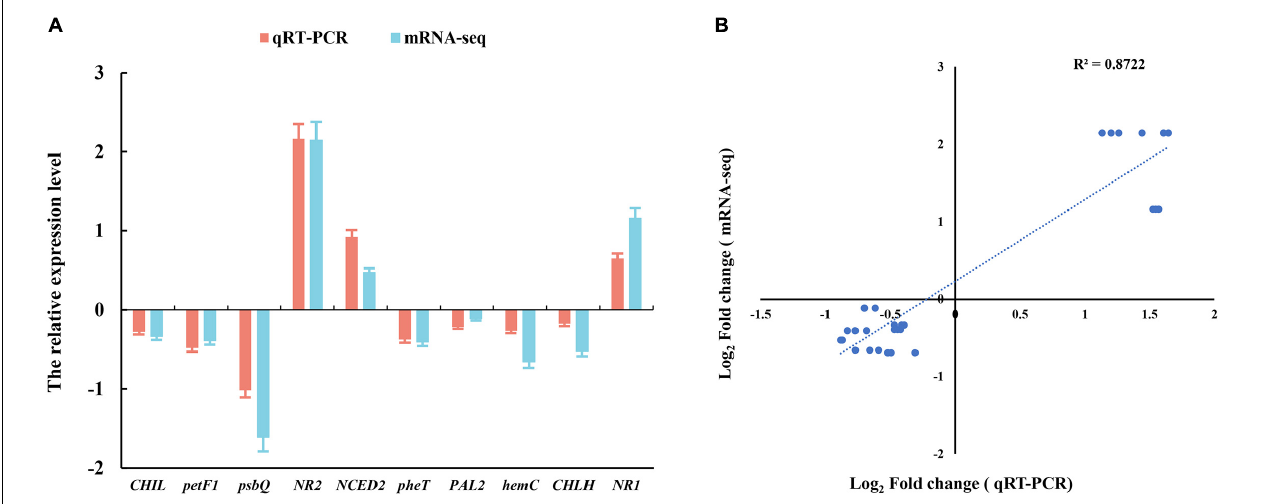
FIGURE 4 | (A) Verification of RNA-Seq data by the quantitative real-time PCR (qRT-PCR) assay. (B) Pearson’s correlation coefficients of the log2 of gene expression ratios obtained from RNA-seq data and qRT-PCR. All the genes information is showed in Table 1 . Three biological replicates and three technical replicates were collected for each sample.